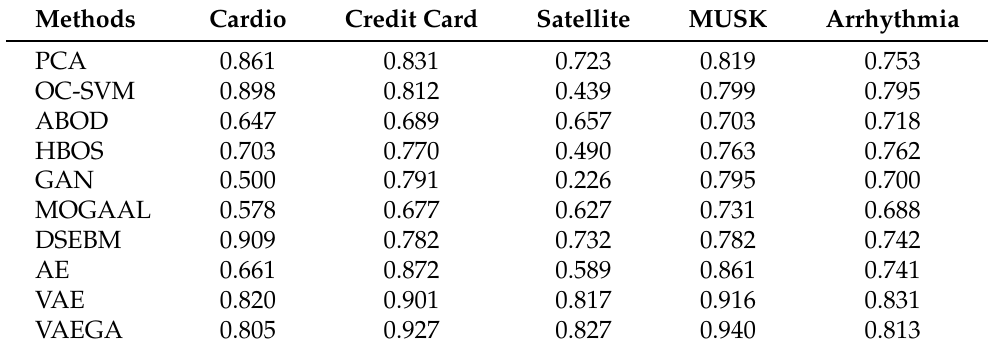
Table 4. F1 scores of 10 models for outlier detection on 5 datasets.